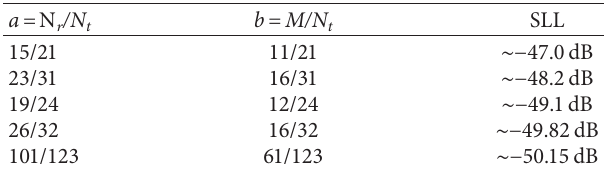
� 48, N � 38, and M � 24, W � 2 . 1. SLL � − 50.53dB. t r 2 Table 2: The ratio of the number of array elements for small SLL of two-way array